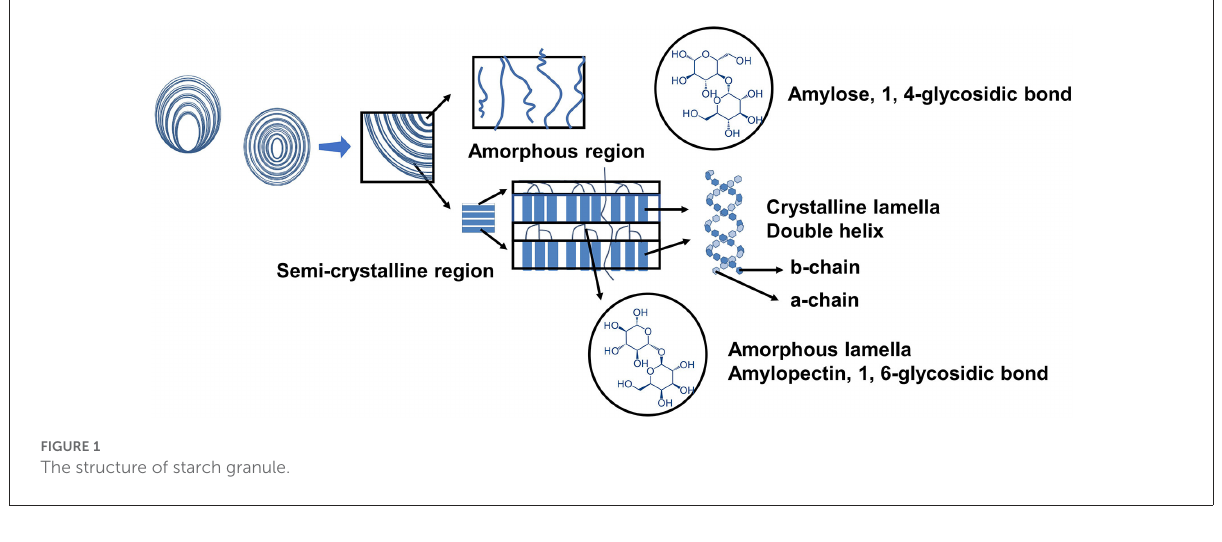
TABLE 1 Effect of microwave treatment on starch crystallinity in food.